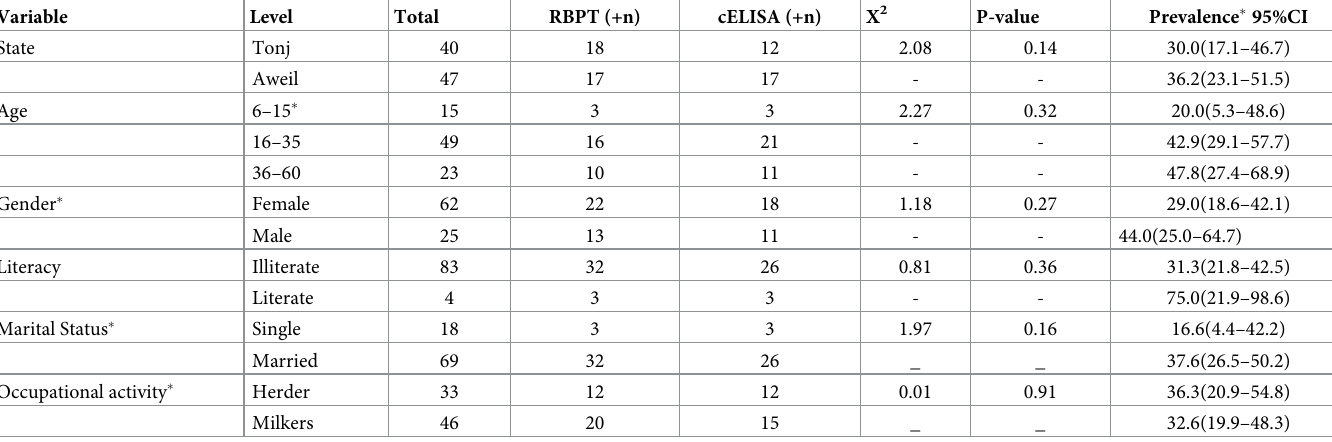
Table 3. Shows the summary descriptive statistics for zoonotic brucellosis among herders in Bahr el